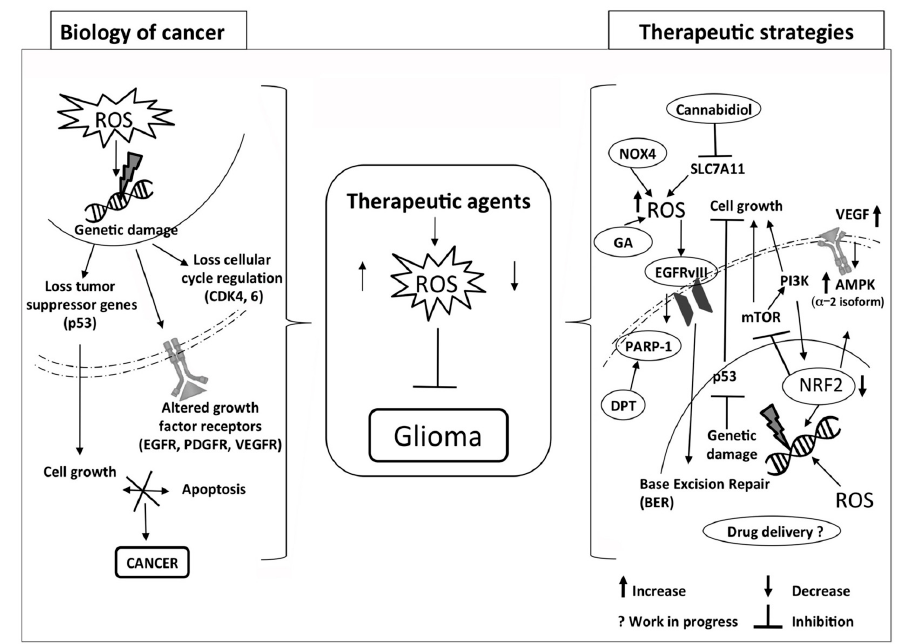
Figure 1. Proposal of therapeutic strategies to selectively modulate ROS pathways in glioma.